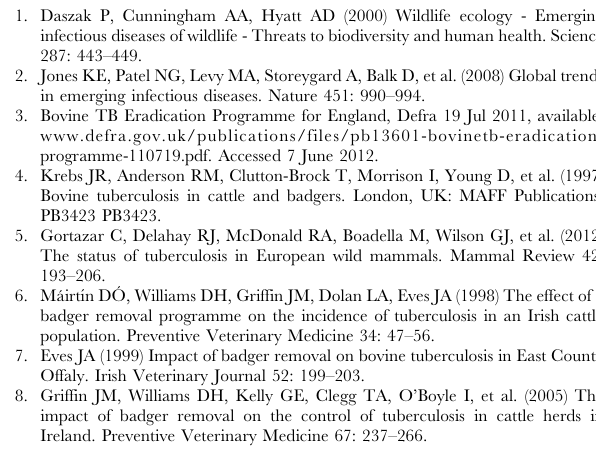
Table S4 The mean proportion of badgers, captured in vaccinate groups at each successive capture event, that had been vaccinated previously. The proportion of all badgers previously vaccinated (A) and previously vaccinated adults only (B) are shown, together with Standard deviation and the number of social groups from which badgers were captured. Capture events prior to or at the start of vaccination (T1–T3) are not listed. Table S5 Simple TB prevalence estimates for the study population over the four years of the study. Estimates are based on the first test result of all badgers captured each year throughout the whole study population (A), groups receiving the vaccinate treatment (B) and experimental control groups where no vaccine was administered (C). Prevalence estimates are provided vaccinated population. Prevalence estimates for Stat-Pak and culture when considered together (dual test) are shown together with those when the results of all three diagnostic tests are considered (triple test v ). Prevalence is derived from the proportion test result (N). Table S6 Factors affecting the likelihood of unvaccinat- ed badger cubs in vaccinate groups testing positive to any of the following diagnostic tests: IGRA (PPDB – PPDA); Stat-Pak; culture, where the proportion of badgers previously vaccinated is modelled as a range of categorical variables